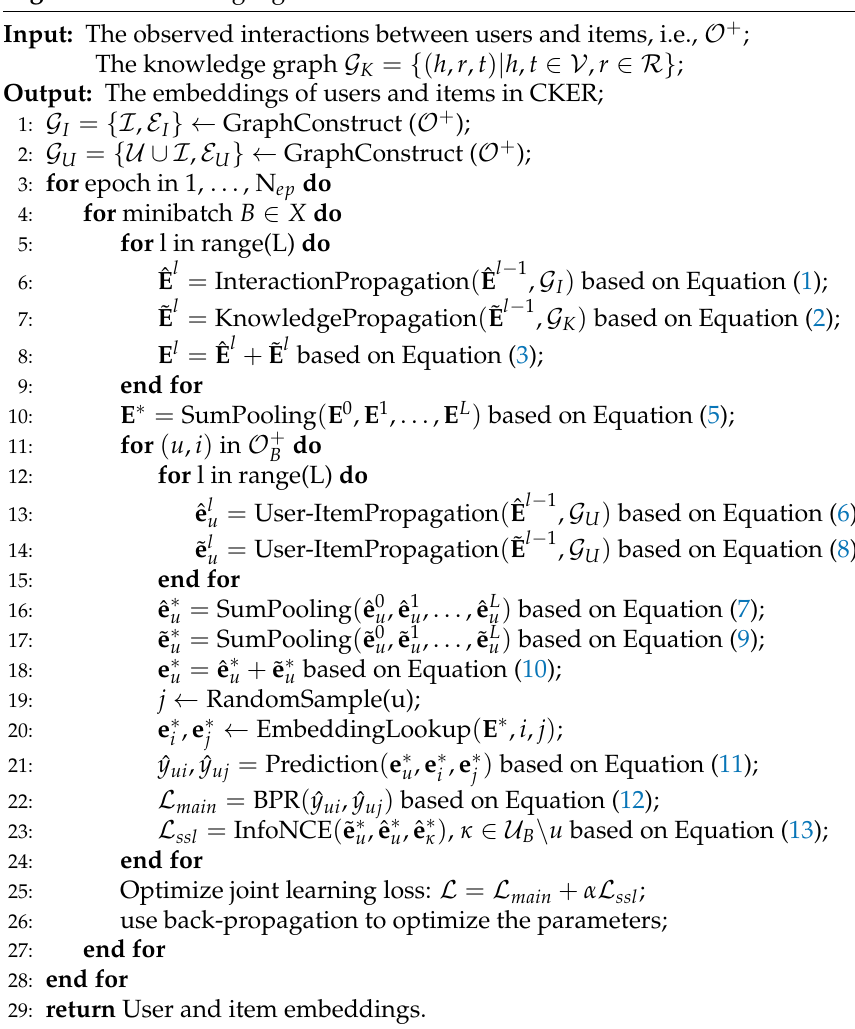
Algorithm 1 Learning algorithm of